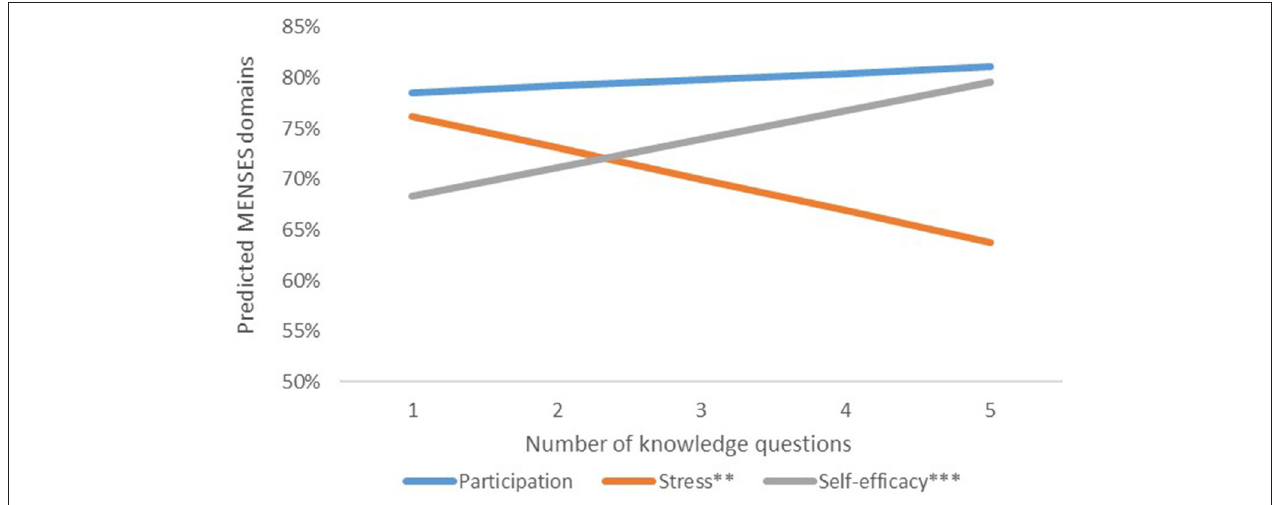
FIGURE 1 | Association between menstrual health and puberty knowledge and MENSES outcomes. * p < 0.05, ** p < 0.01, *** p < 0.001.